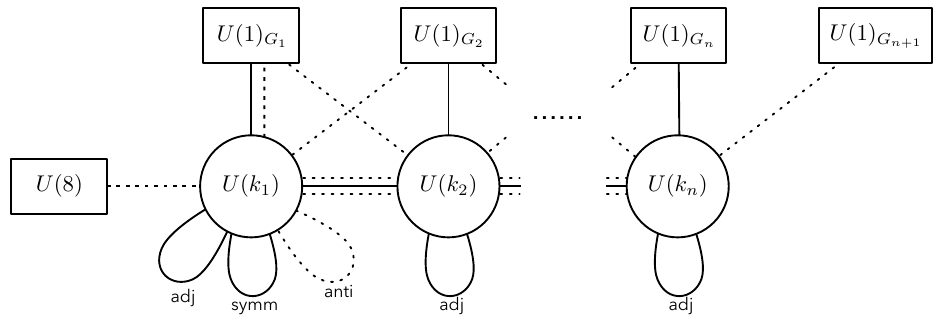
Figure 7. UV gauge theory for string chain on multiple M5-branes probing